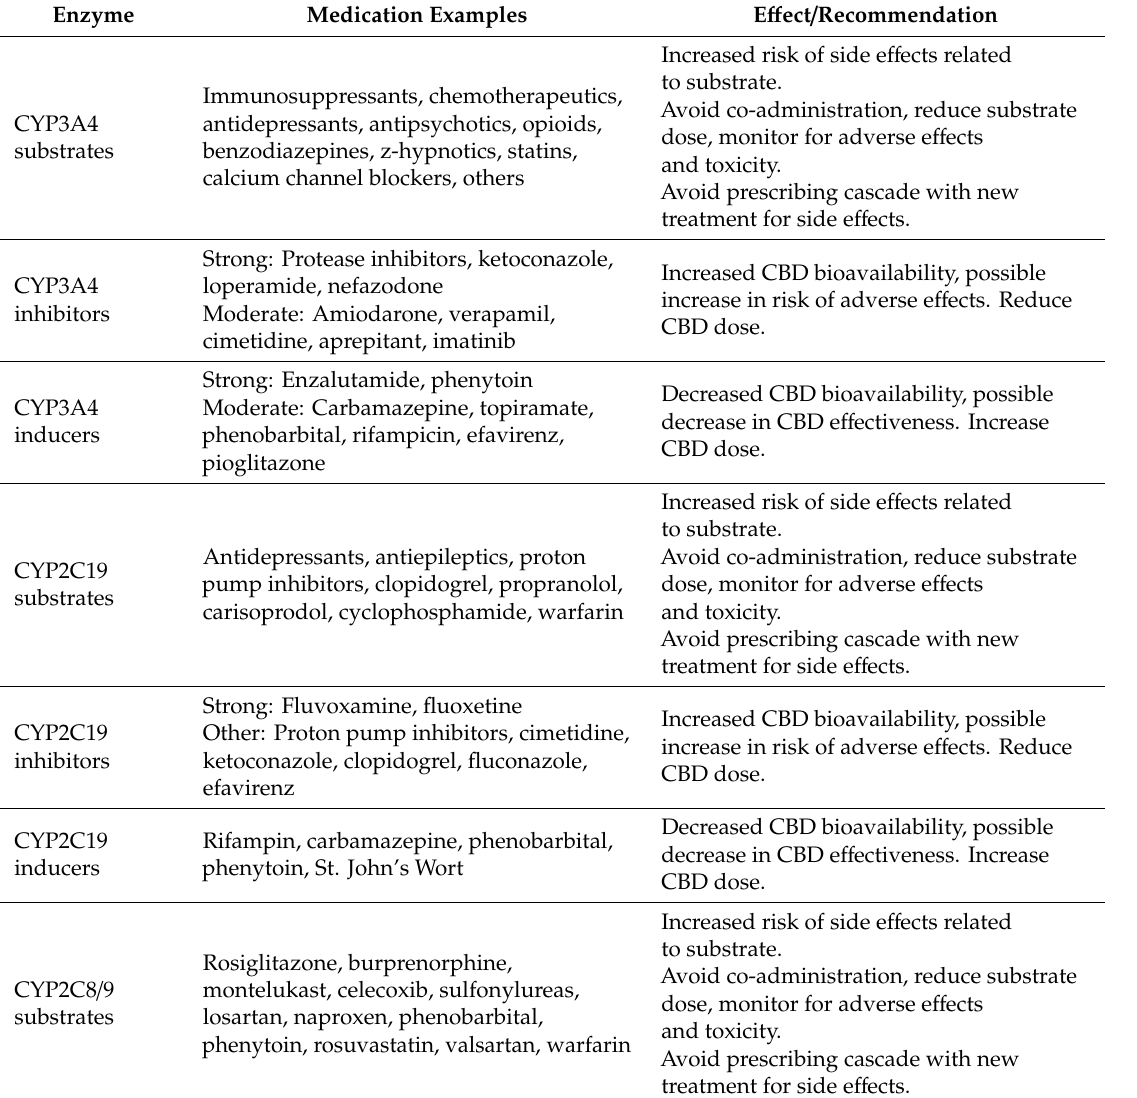
Table 2. Metabolic drug–drug interactions between cannabidiol and enzyme substrates, inhibitors, or